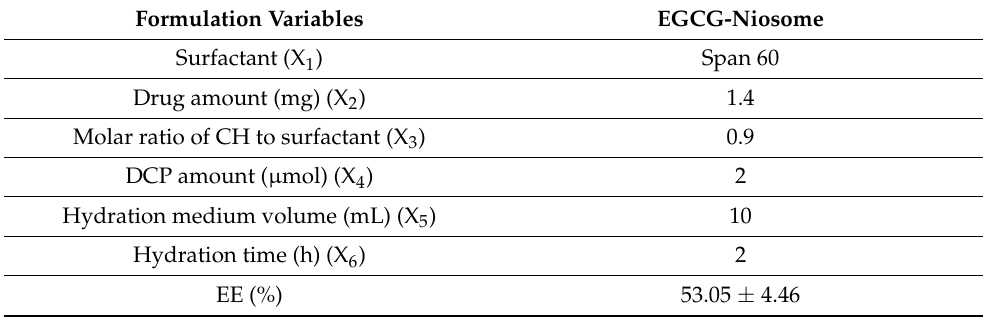
Table 8. Optimised formulation composition for EGCG-niosome.